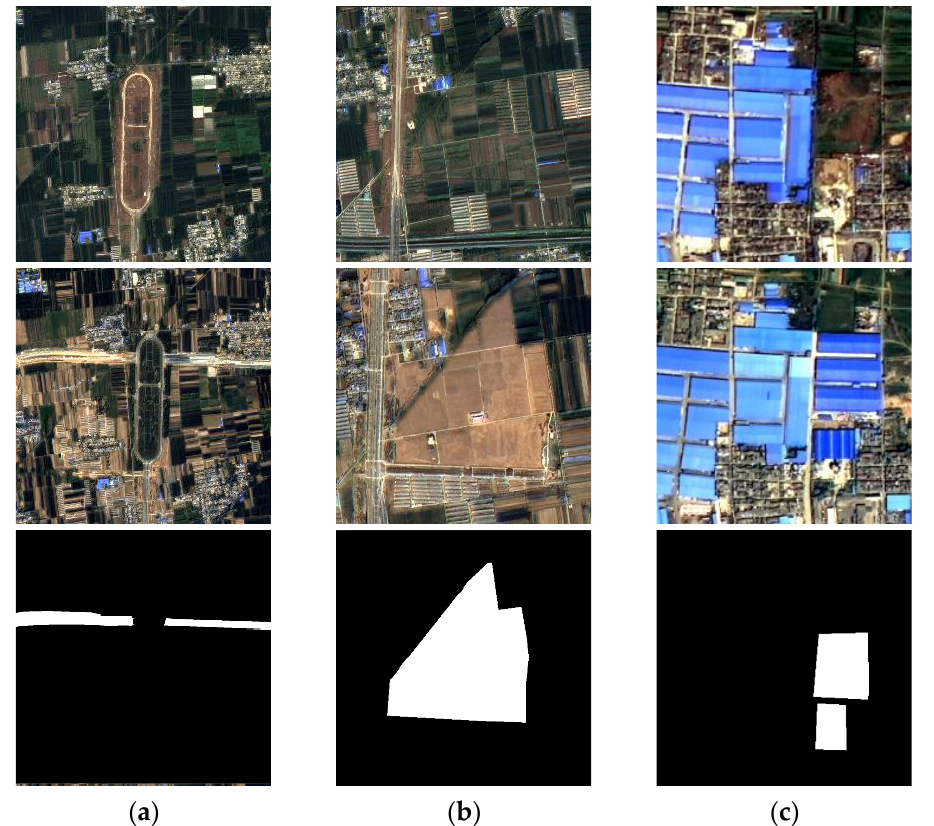
Figure 4. Change types in XI’AN-CDD: ( a ) road change, ( b ) cultivated land change, and ( c ) building change.